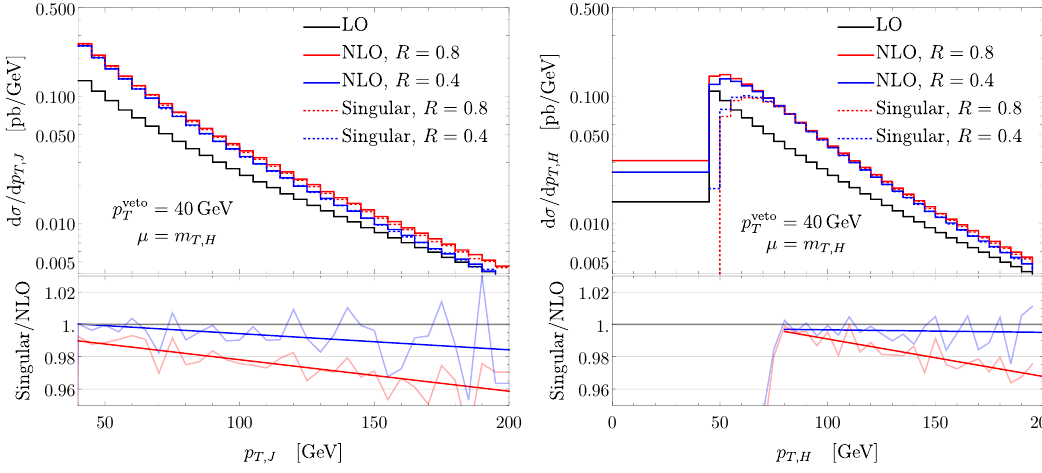
Figure 4 . The full NLO prediction (solid lines) for exclusive Higgs + 1 jet production for the jet (left) and Higgs (right) transverse momentum distributions with p veto the NLO singular prediction in eq. (4.2) (dotted lines). The anti- k T jet algorithm with R = 0 : 8 (red) and R = 0 : 4 (blue) is used. The LO cross section (solid gray) is shown for comparison. The lower panels show the ratio of the singular and NLO predictions (more transparent line) as well as a linear (cid:12)t of this ratio to clarify the trend (more